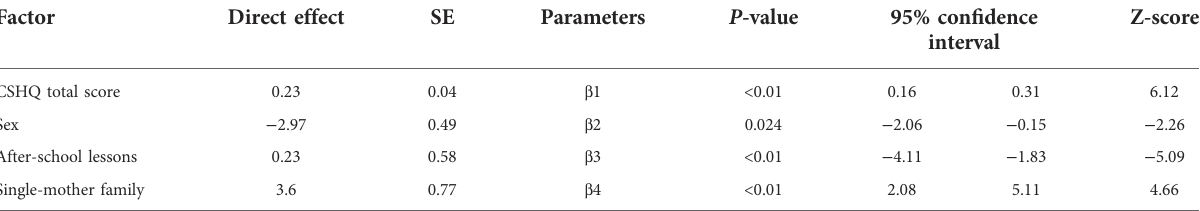
TABLE 5 Direct effects of factors on the SDQ total